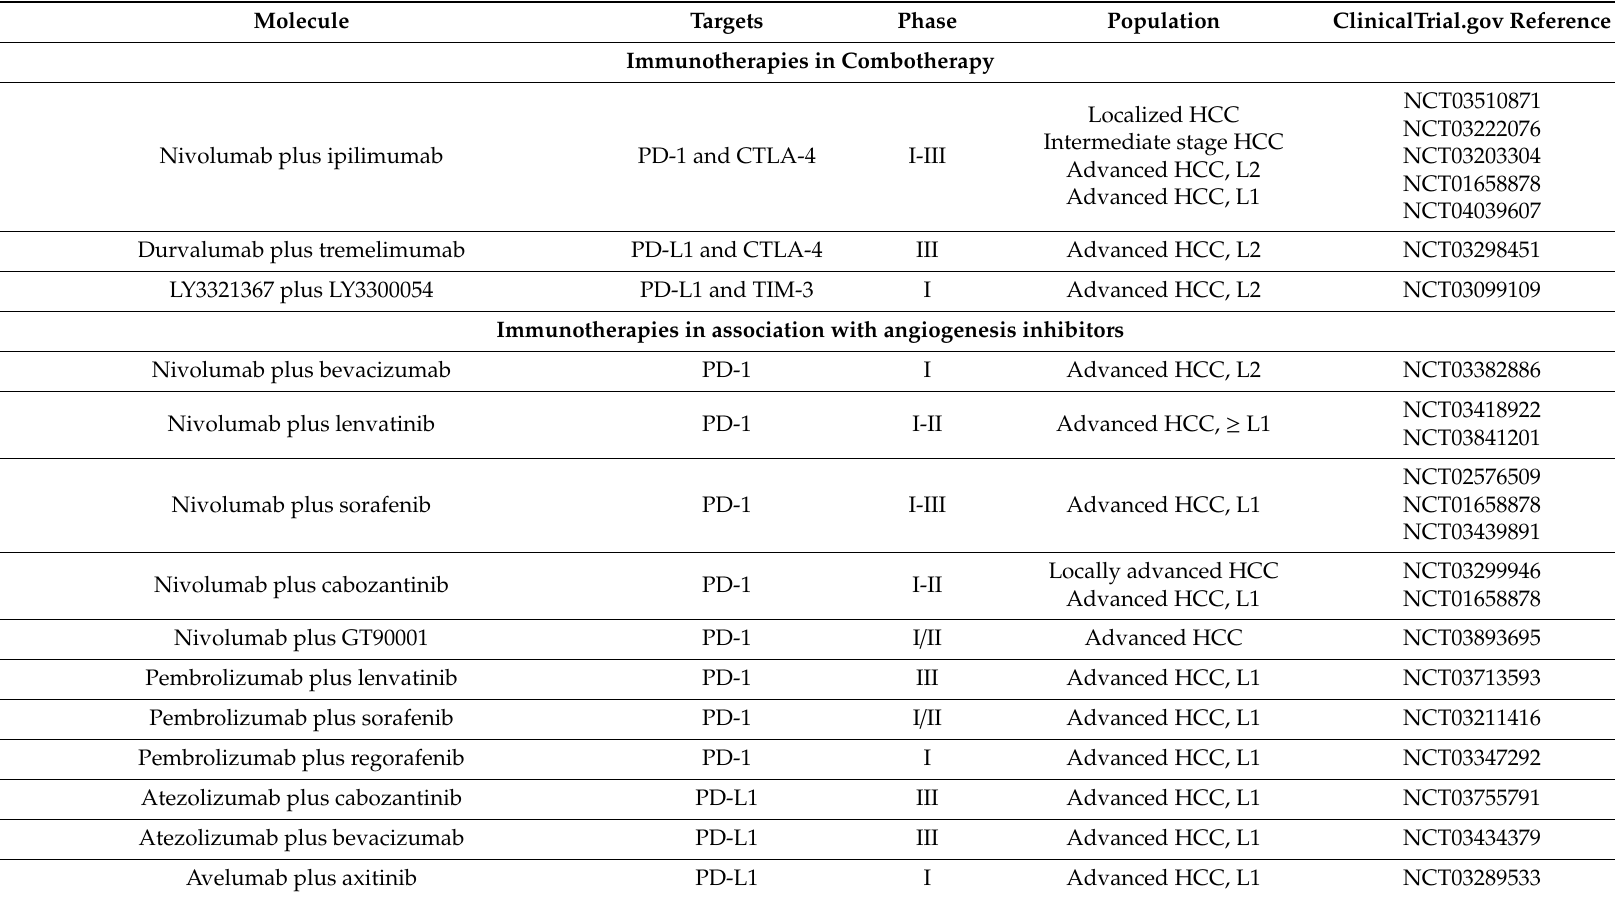
Table 2. Ongoing combination trials evaluating immune therapies in hepatocellular carcinoma 1